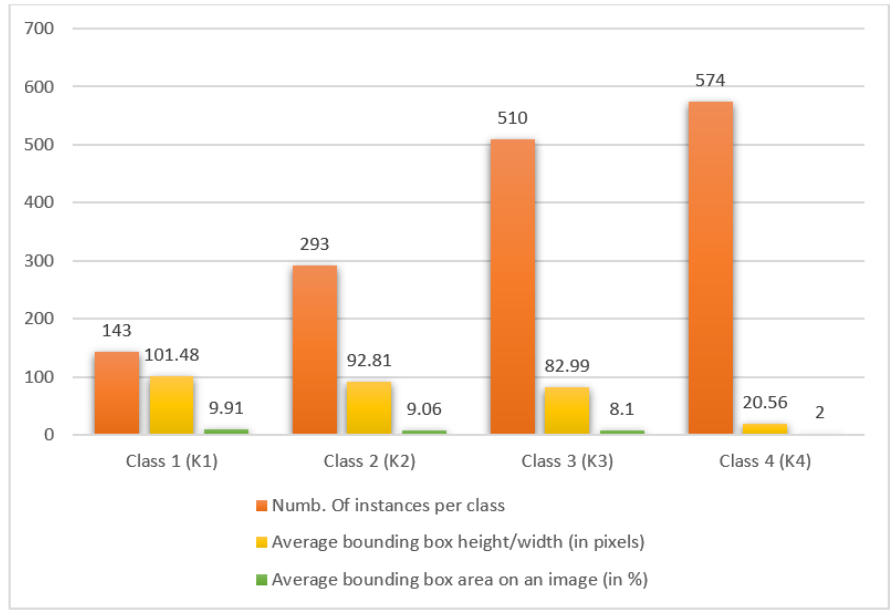
Figure 7. Analysis graph of the Magellan data